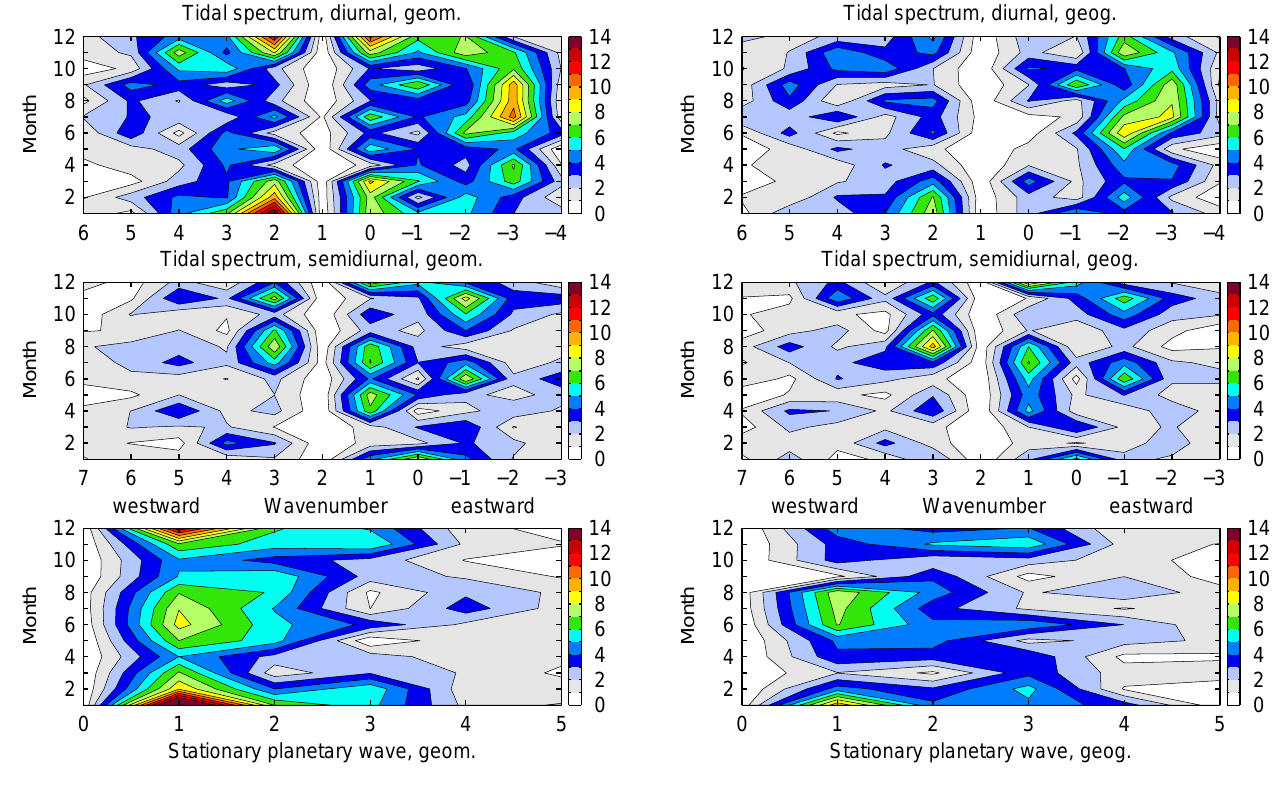
Fig. 4. Diurnal (top) and semidiurnal (middle) tidal spectra of the zonal wind [m/s] along the geomagnetic equator (left panels) and the geographic equator (right panels). Bottom panels display the stationary planetary waves.